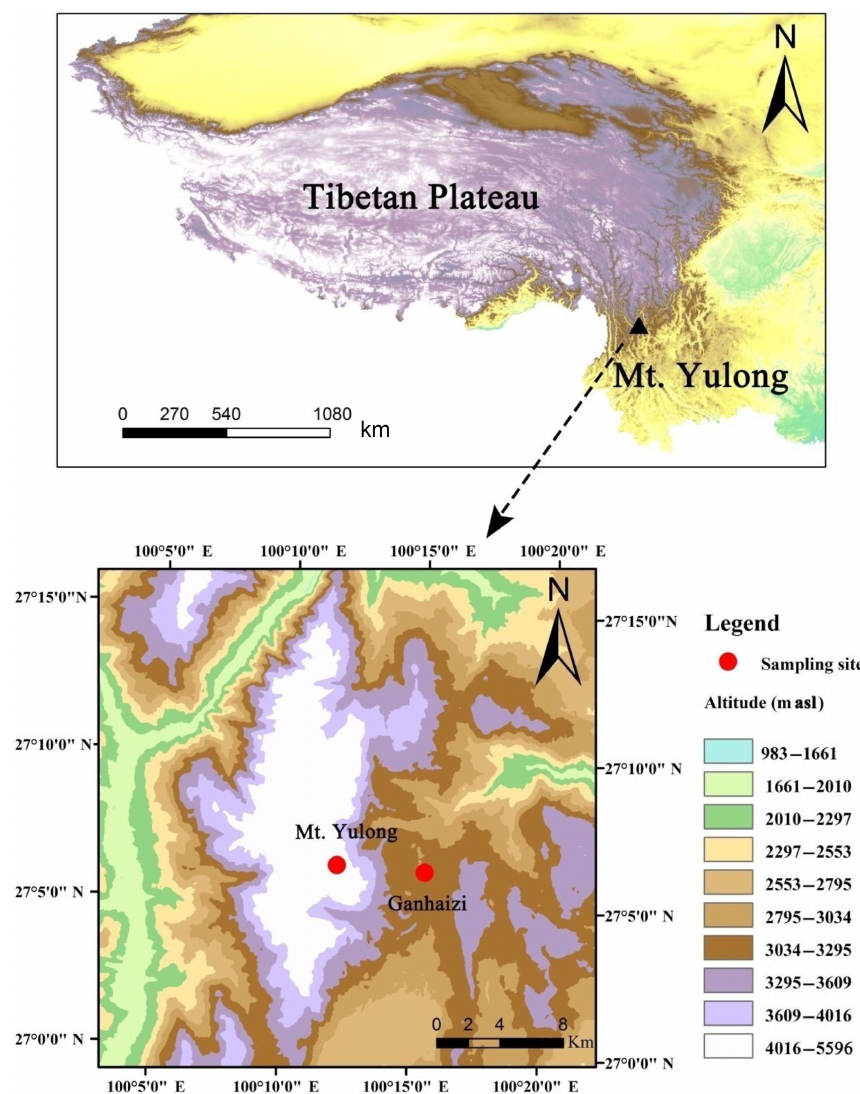
Figure 1. Location of Mt. Yulong in the Tibetan Plateau and the sampling sites at the Mt. Yulong and Ganhaizi basin.